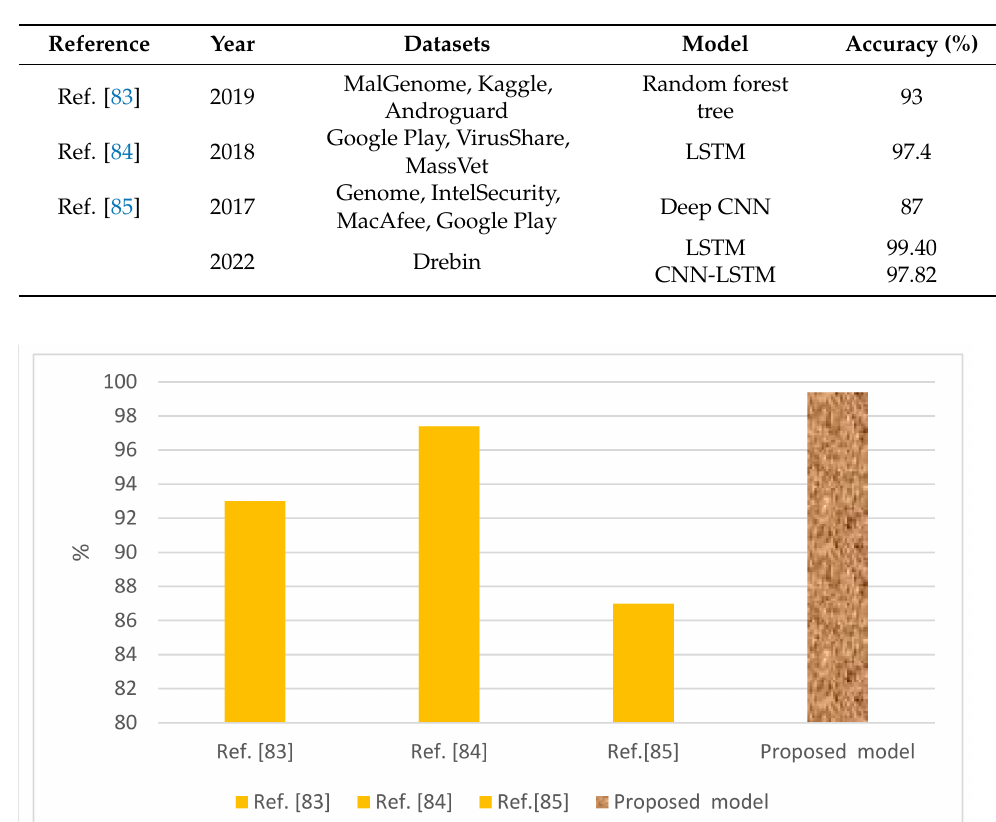
Figure 22. Comparative performance of the proposed system against existing systems in the detection of malware against Android applications using different